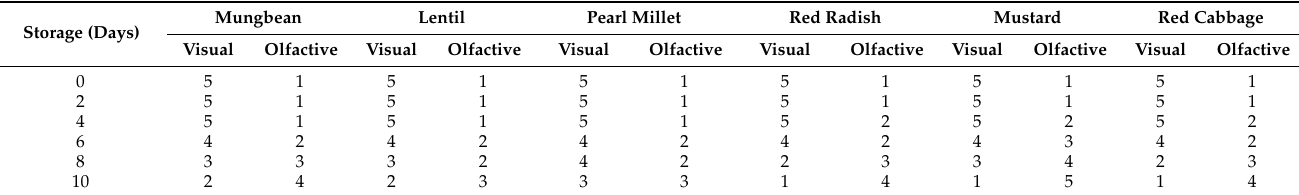
Table 9. Sensory attribute scores of all six selected microgreens on the day of